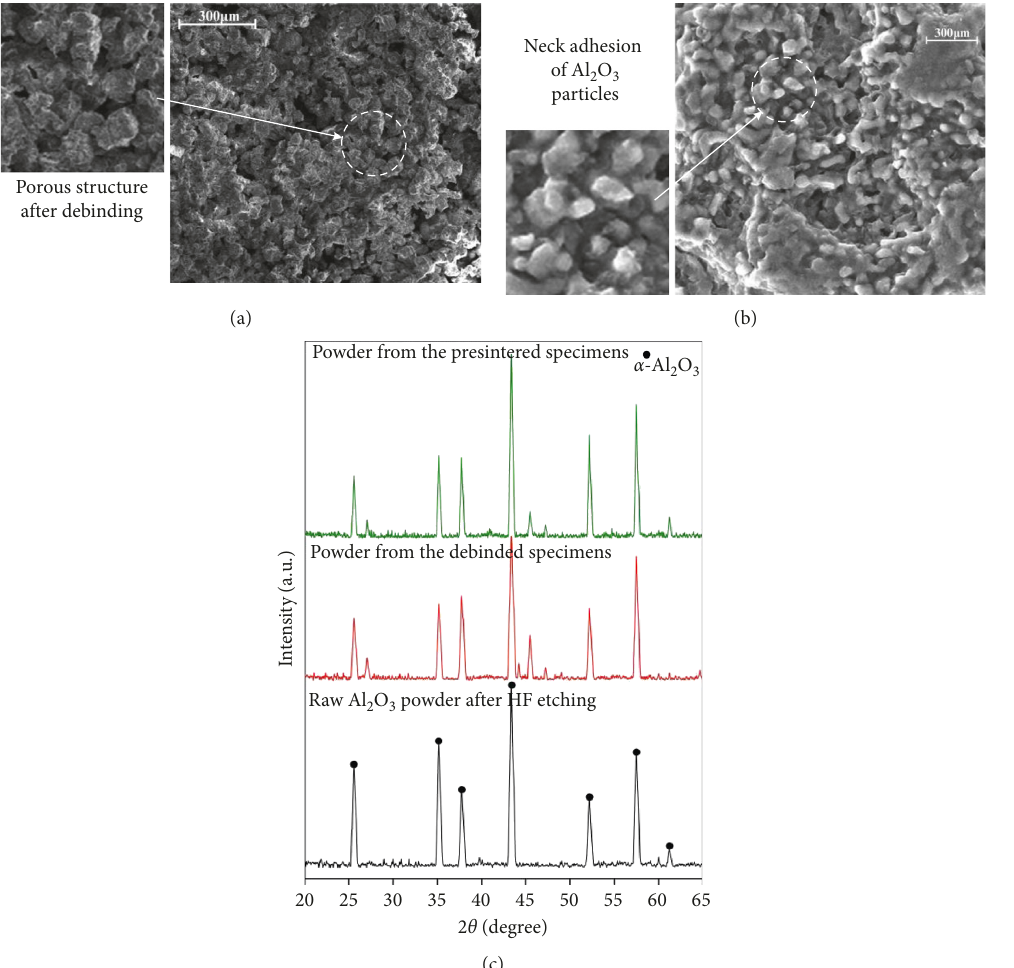
Figure 12: (a) Specimens’ microstructures after debinding. (b) Specimens’ microstructures after presintering. (c) XRD results for debinded specimens, presintered specimens, and the as-received raw Al 2 O 3 powder.